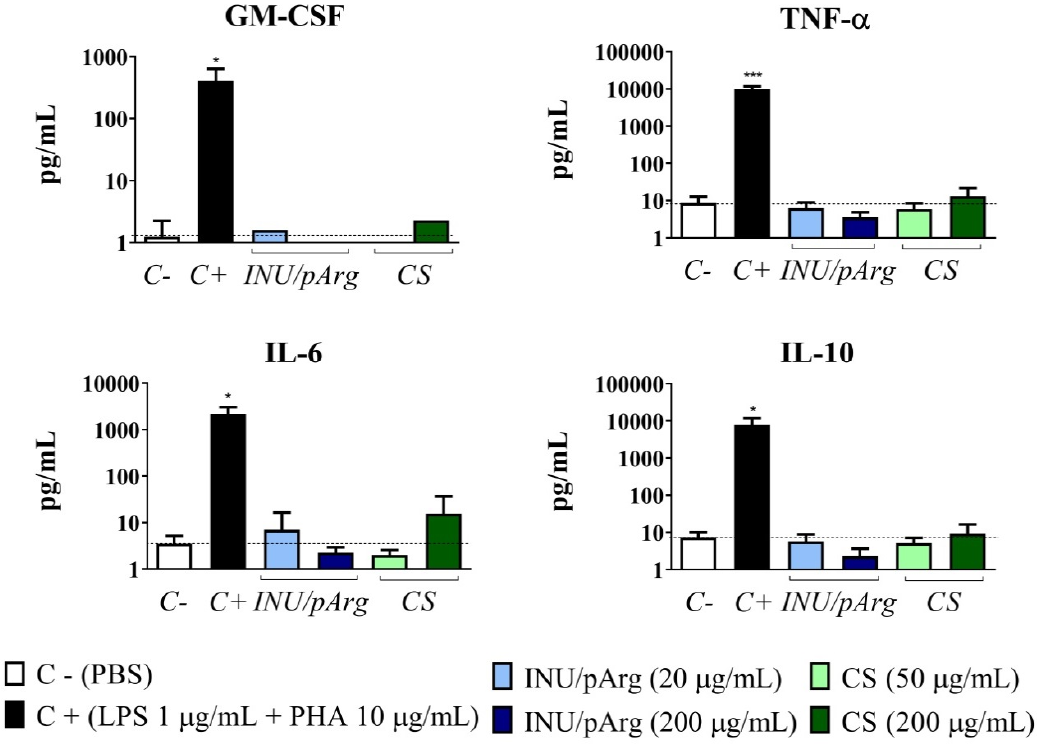
Figure 7. GM-CSF, TNF-α, IL-6, and IL-10 concentrations induced by Imiquimod-loaded CS and INU/pArg nanocapsules in PBMCs from healthy donors after 24 h of incubation. PBS was used as negative control and LPS+PHA as positive control. GM-CSF: granulocyte monocyte-colony stimulating factor, TNF-α: tumor necrosis factor alpha, IL-6: interleukin 6, IL-10: interleukin 10, CS: Chitosan, INU: Inulin, pArg: Polyarginine. Statistical significance: * P ≤ 0.05, *** P ≤ 0.001.